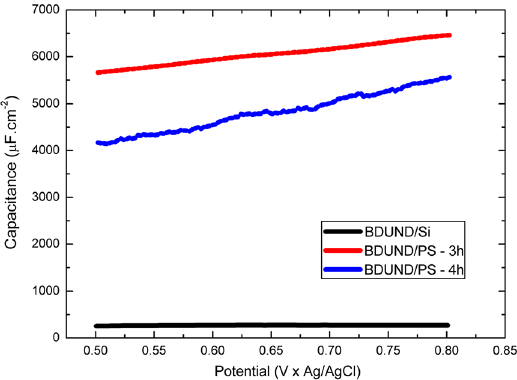
Figure 8. Capacitance values for the three electrodes.